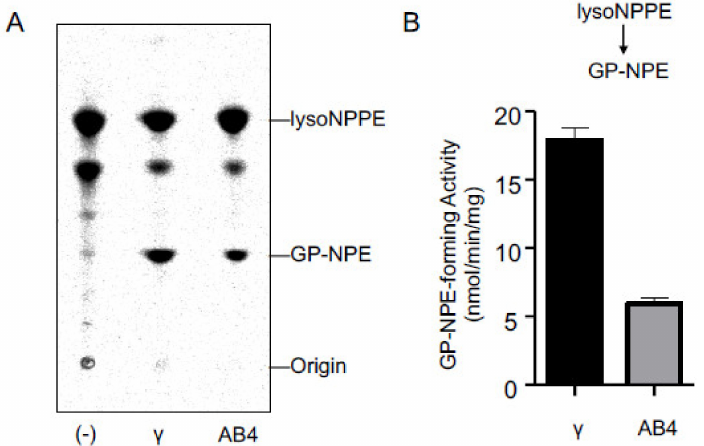
Figure 5. Reactivity of cPLA 2 γ and ABHD4 with lysoNAPE. The purified cPLA 2 γ and ABHD4 (AB4), as well as buffer alone (-) were allowed to react with N -[ 14 C]palmitoyl-lysoPE (lysoNPPE), and the products were then analyzed by TLC ( A ). The positions of the origin and authentic compounds are shown. The GP- N -[ 14 C]palmitoylethanolamine (GP-NPE)-forming activity is shown (mean values ± S.D., n = 3) ( B